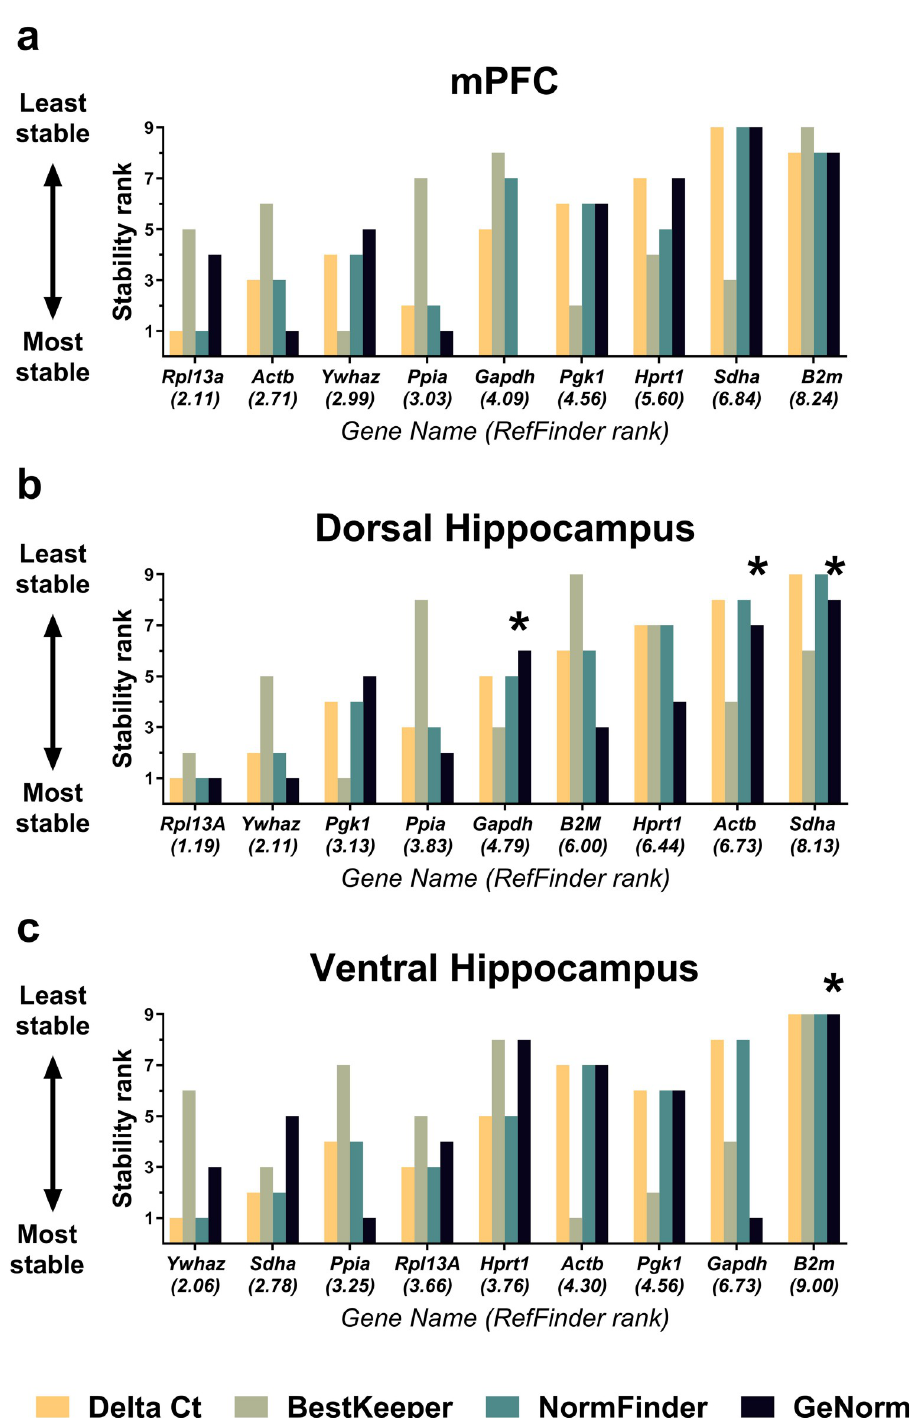
Fig 3. Reference gene stability rankings in three brain regions of rats fed with MCT. MCT (2 ml/kg body weight) were given as a supplement to standard feed to adult animals (9 m.o., BW = 444 ± 69 g) by oral gavage daily for 4 weeks, while control rats received equivolume water. Reference gene stability in the (a) medial prefrontal cortex, (b) dorsal and (c) ventral hippocampal areas was analyzed by RefFinder 1 online tool. RefFinder comprehensive ranking (ranks are indicated in brackets under gene name on X-axis) is based on geometric mean of ranks obtained by four methods: comparative Delta-Ct, BestKeeper, NormFinder, and GeNorm. � –unstably expressed genes inappropriate for normalization, according to the GeNorm cut-off 0.5